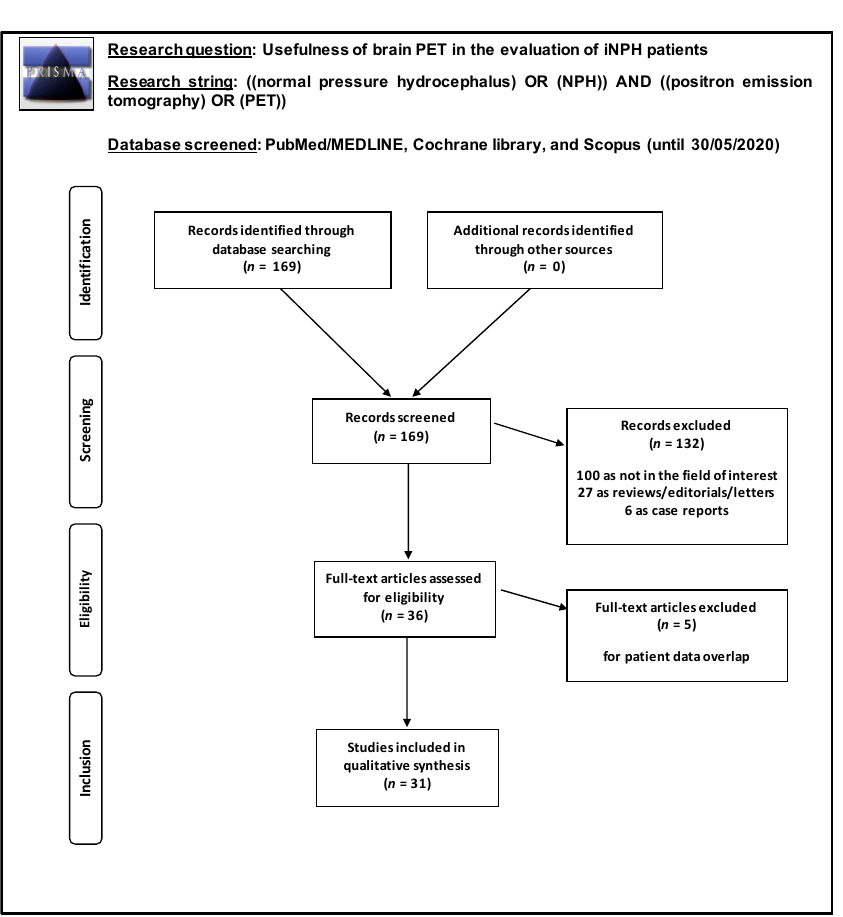
Figure 1. Flow chart of the search for the systemic review on the usefulness of brain positron emission tomography (PET) with different tracers in patients with iNPH patients.